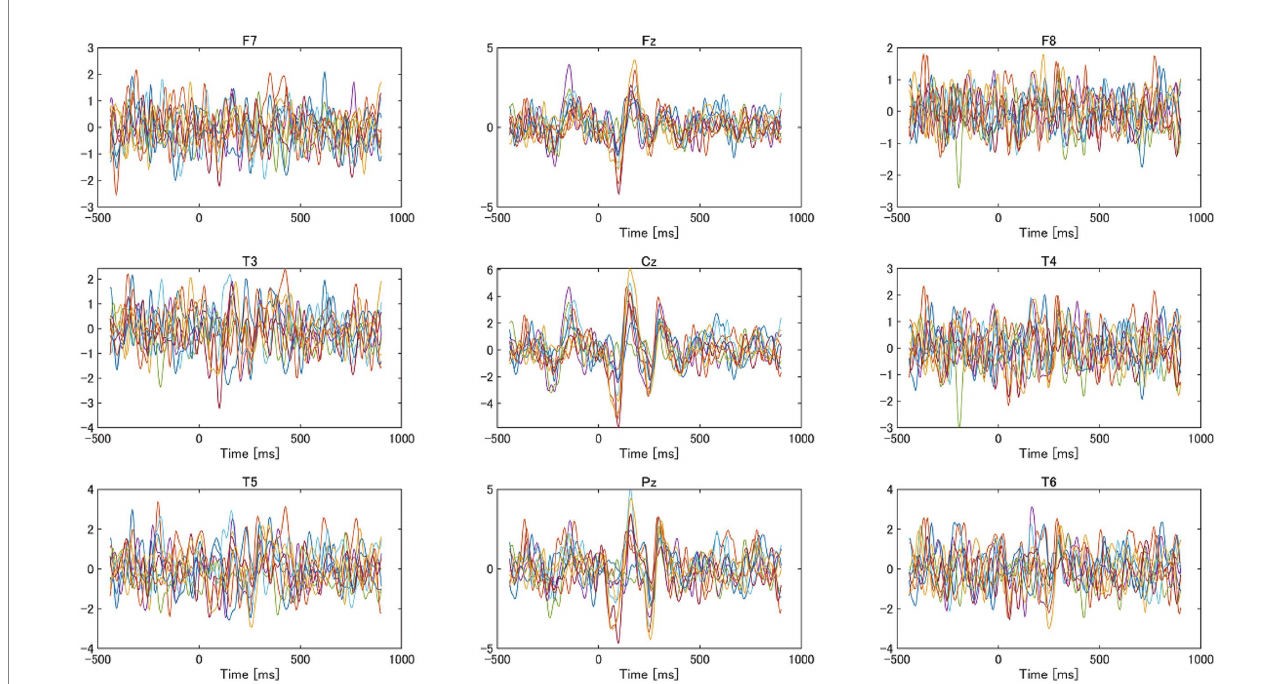
FIGURE 7 Auditory evoked responses (AEPs) observed at nine electrodes from a participant. The color of the lines indicates each AEP evoked by each impulsive